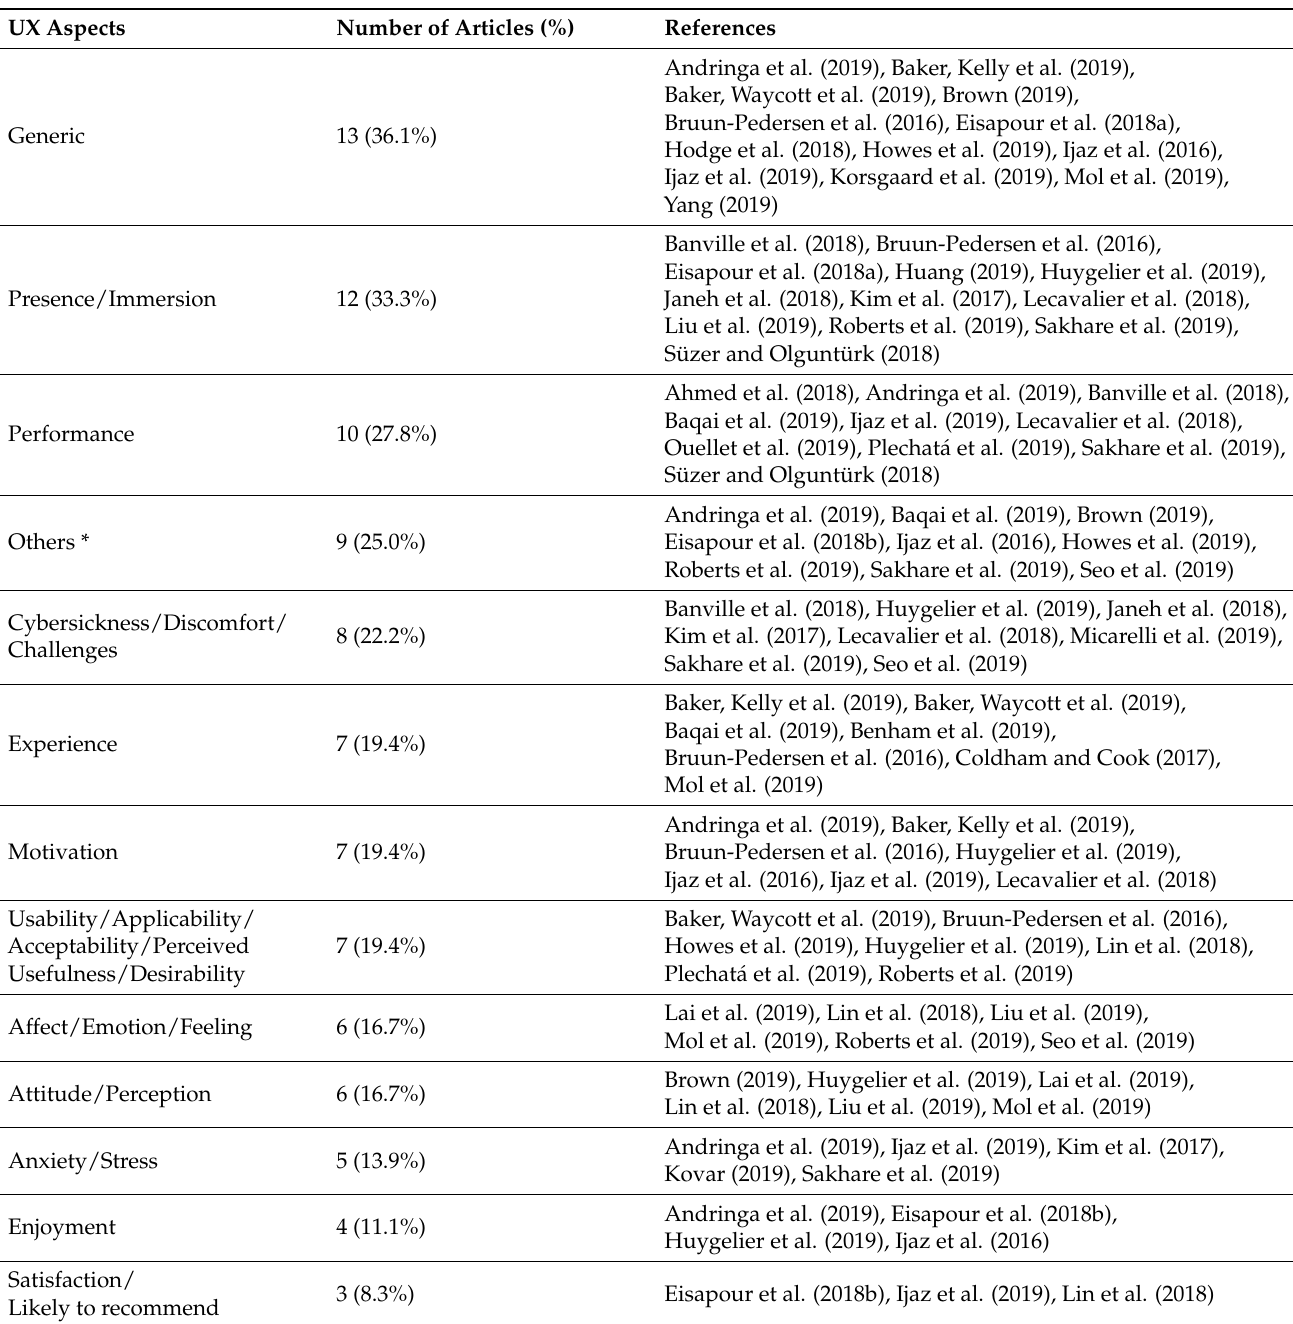
Table 3. Evaluated UX